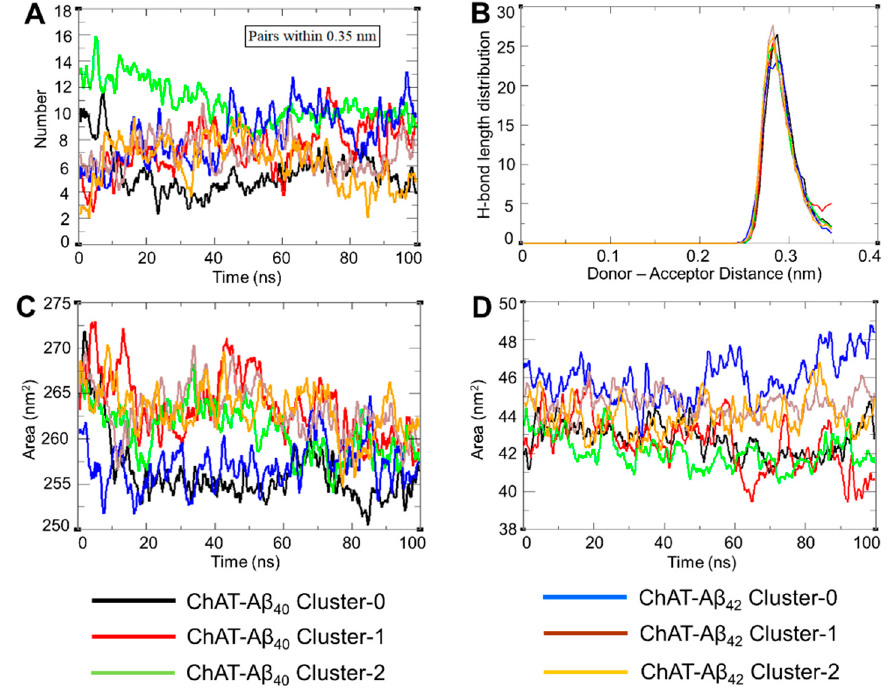
Figure 4. The ChAT-A β complex formation and stabilization based on hydrogen bonding landscape analysis. H-bonding plays a central role during protein interactions; thereby ( A ) shows the average number of hydrogen bonds formed between ChAT-A β peptides during 100 ns simulation trajectory. ( B ) illustrates the average hydrogen-bond distance around the cut-off for donor–acceptor distance that was set at 0.35 nm. ( C , D ) denote the change in total solvent accessible surface area (SASA) of the ChAT protein and the total solvent accessible surface area of the A β peptides, respectively, corresponding to the simulation time-period of the complex system. The clusters are represented by the given color scheme.